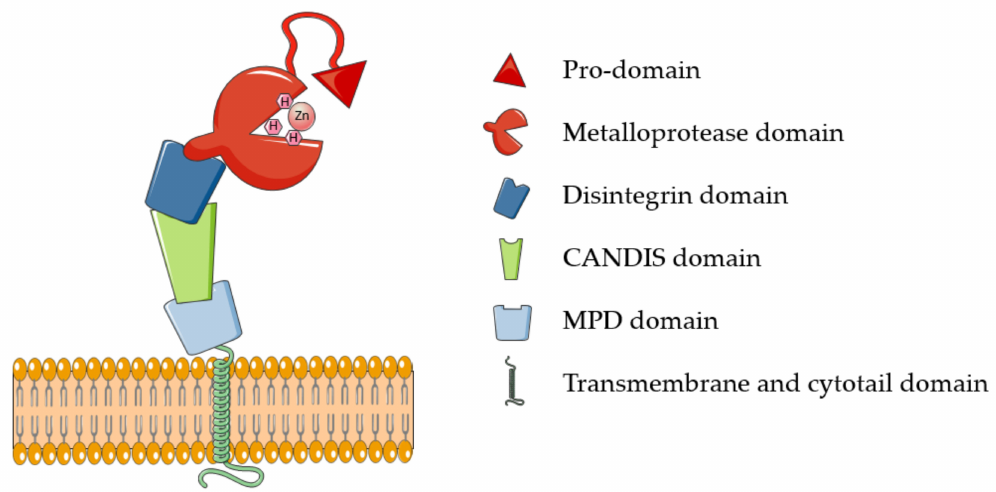
Figure 1. Schematic representation of ADAM17. ADAM17 comprises six different domains, here depicted with different shapes and colors: a pro-domain that constraints the proteolytic activity elicited by the metalloprotease domain. CANDIS: conserved ADAM seventeen dynamic interaction sequence; MPD: membrane proximal domain.